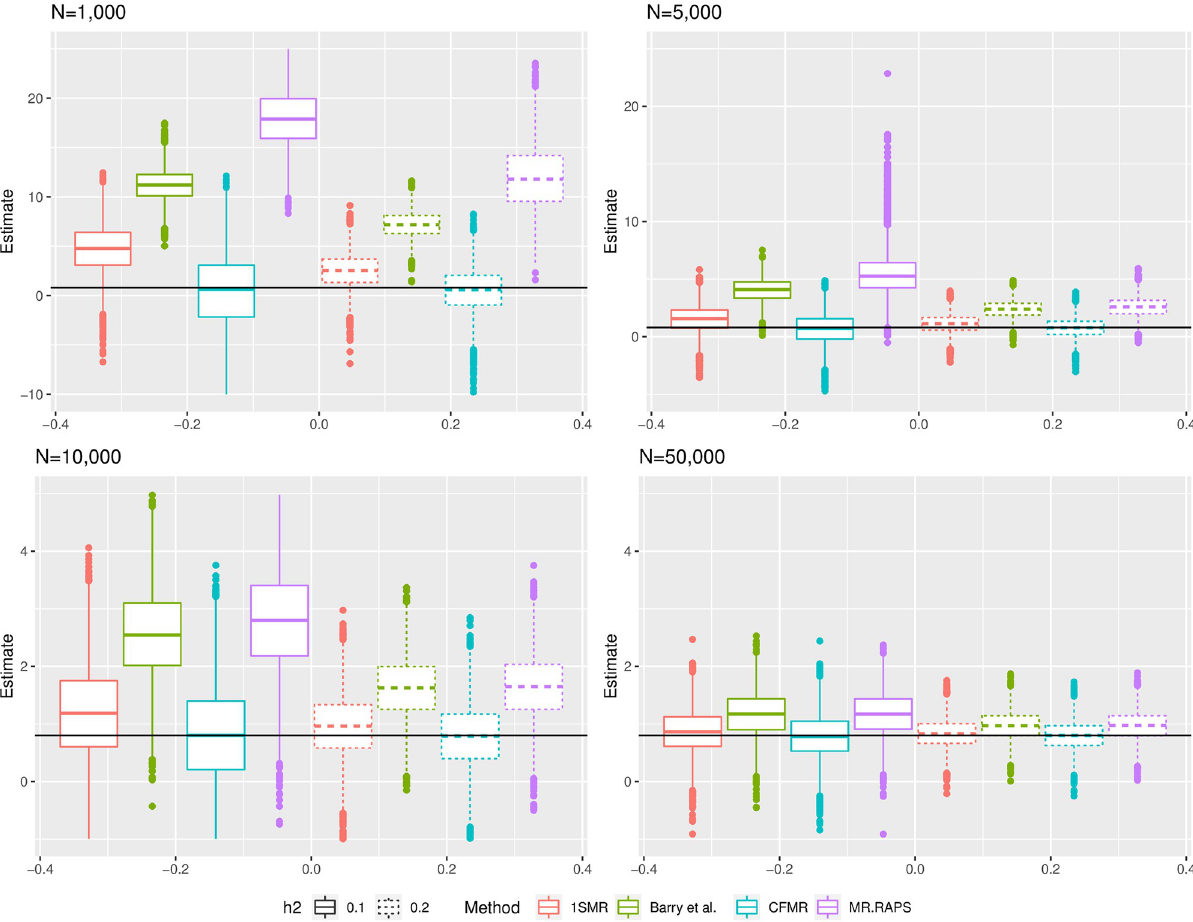
Fig 3. Summary of the results of the simulations to assess bias due to complete sample overlap and weak instruments across different MR methods. For details, see Section 3.2 in the main text. Each panel displays the box plots of the estimated effect according to method used (1SMR, Barry et al. [26], CFMR, and MR RAPS) and sample size (1000, 5, 000, 10, 000, and 50, 000). The y-axis corresponds to the estimated effect. The solid horizontal black line corresponds to the true value of the effect to be estimated. The different types of box plots correspond to the variance X explained by the genetic marker used as instruments (10% and 20%). The red box plots correspond to the estimates based on one-sample MR, the green box plots the estimates based on the Barry et al. [26] method, the purple box plots the estimate using MR RAPS, and finally, the blue box plots the estimates using